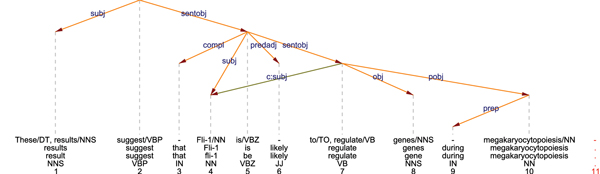
Example of Dependency Tree. Tree of dependencies for a GENIA sentence, along with other linguistic annotations. Notice the additional deep-linguistic "control" subject dependency between token 7 and 4.